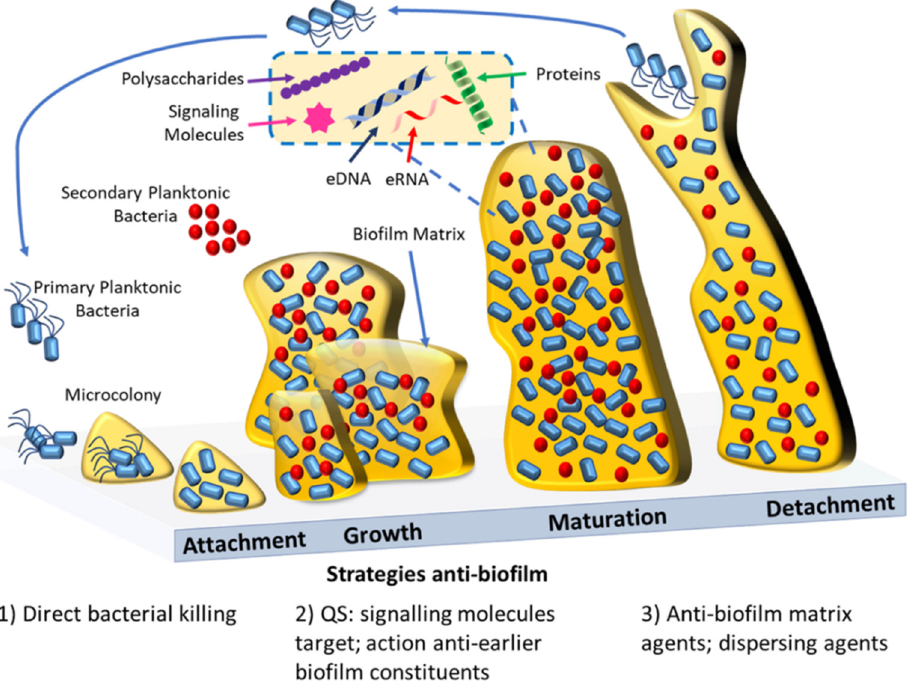
Figure 2. Schematic representation of biofilm formation and the current antibiofilm strategies. Biofilm formation starts with the initial reversible attachment of bacterial cells to a surface, then follows the growth of the biofilm within a matrix; maturation of the biofilm; and finally, when the environment conditions cease to be ideal, the reversal of the attachment with the dispersion of the cells that will colonize other superficies. Antibiofilm agents are capable of inhibiting the biofilm formation by bacteriostatic effects (1), e.g., antimicrobial polymers, or by acting against important early biofilm constituents (2), e.g., quorum sensing inhibitors. Mature biofilm can be disrupted by direct action against the biofilm matrix (3), e.g., biofilm matrix-degrading enzymes. Alternatively mature biofilms can be perturbed by the use of dispersing agents (3), e.g., nitric